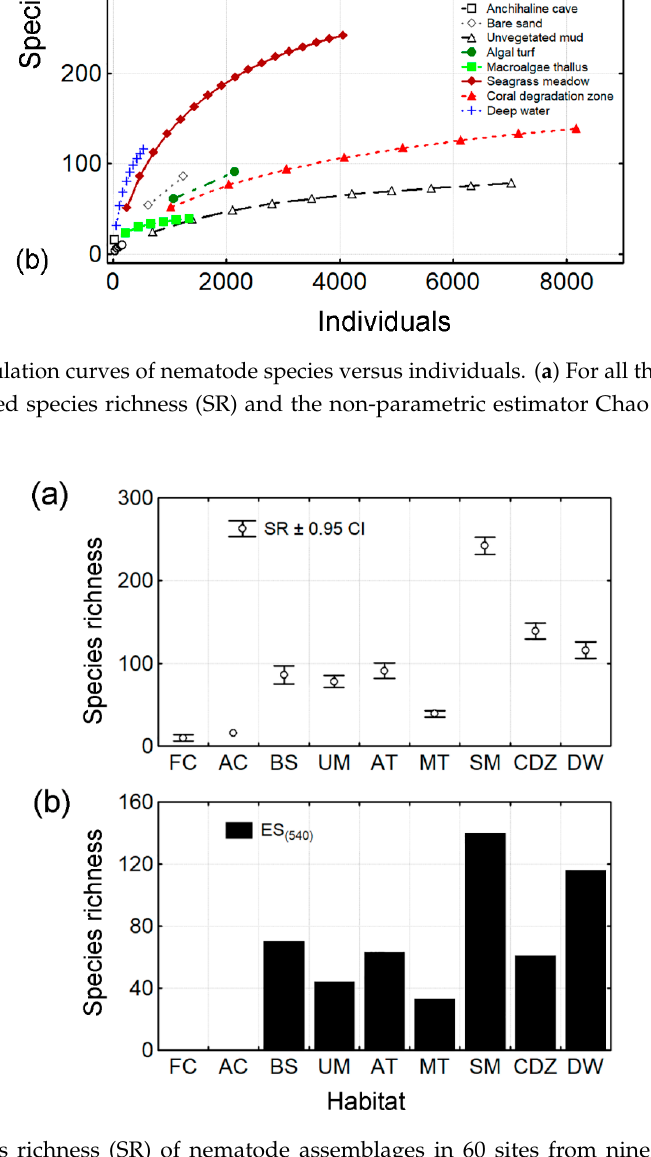
Figure 3. Species richness (SR) of nematode assemblages in 60 sites from nine aquatic habitats. ( a ) Observed SR ± 0.95 confidence intervals (CI); ( b ) Expected number of species (ES) in a subsample of 540 individuals. Note that ES (540) was not computed for two habitats due to their low abundance. Acronyms of the habitats: FC = freshwater cave, AC = anchihaline cave, BS = bare sand, UM = unvegetated mud, AT = algal turf, MT = macroalgae thallus, SM = seagrass meadow, CDZ = coral degradation zone, and DW = deep water.